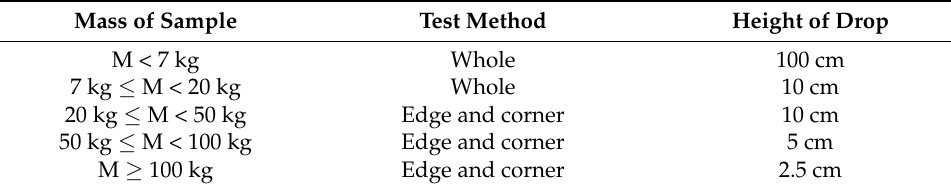
Table 4. Specifications of the drop test methods in IEC 62619-2022 (Adapted from [70]). Mass of